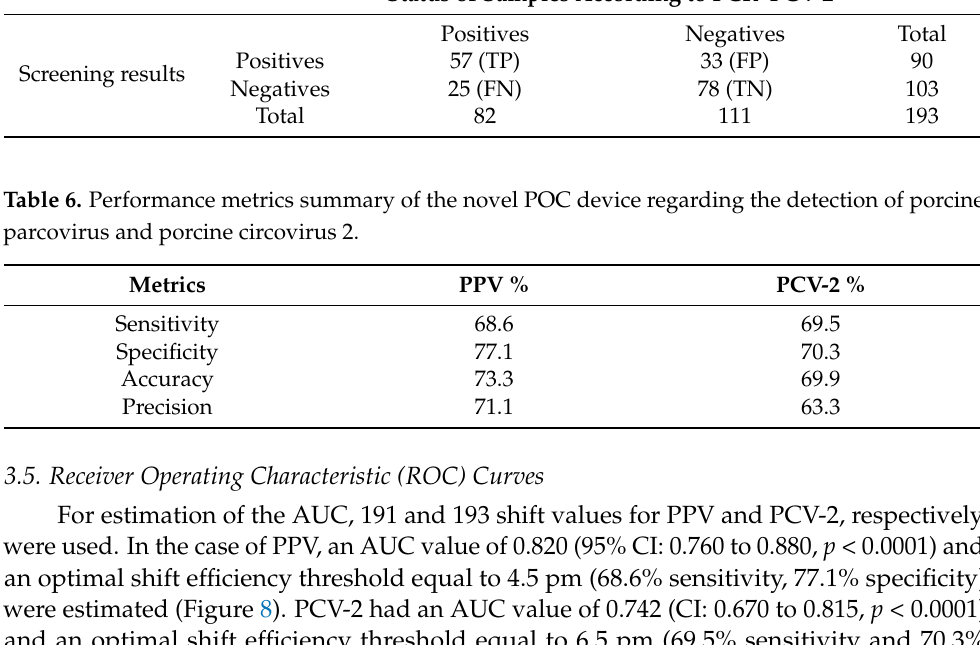
Figure 9. ROC curves for PPV and PCV-2 after the exclusion of the outlier, PIC #45. The dashed line represents the diagonal reference line. ( A ) PPV ROC curve, AUC = 0.892, CI: 0.840 to 0.944, p < 0.0001 and ( B ) PCV-2 ROC curve, AUC = 0.788, CI: 0.712 to 0.863, p < 0.0001. 4. Discussion The present study demonstrated that PICs, and photonics in general, can be com- bined with emerging technologies (microfabrication, microfluidics, modern data acqui- sition, and communication strategies) to be successfully integrated into a compact, port- able device that is fit for POC testing, for the label-free detection of swine viral diseases in oral fluids. The diagnostic performance of the device was satisfying, achieving sensitivity values of 68.6% and 69.5%, specificity values of 77.1% and 70.3%, and AUC values of 0.820 and 0.742 for PPV and PCV-2, respectively. Further testing and optimization of PIC and device fabrication procedures are expected to significantly improve the performance of the device.